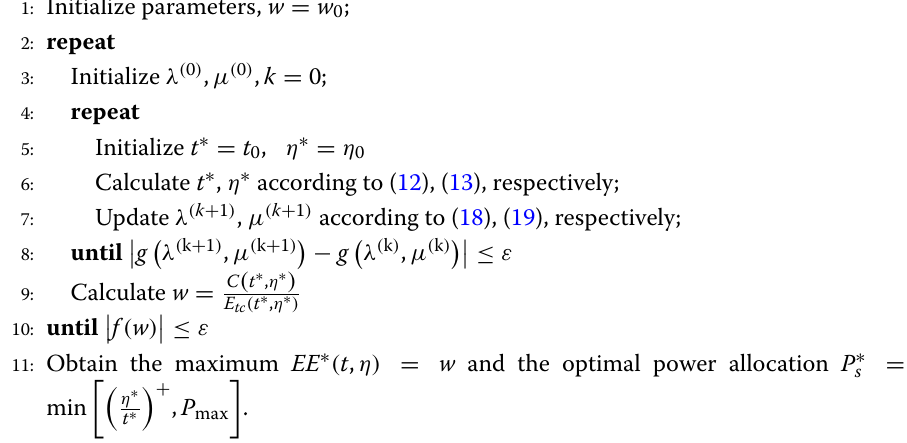
Algorithm 1 The energy-efficient resource allocation policy related to harvesting time and transmitting power under QoS